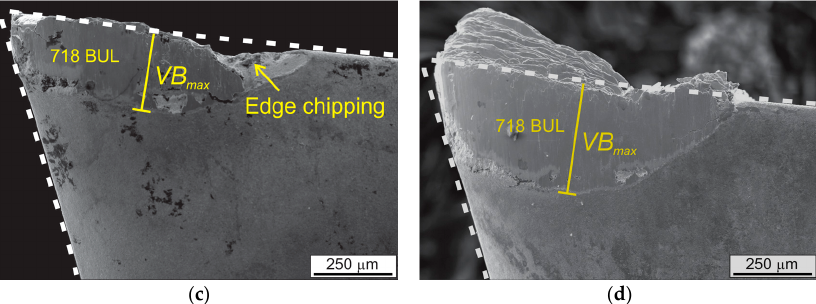
Figure 3. Scanning electron microscope (SEM) images of Tool dry1 side flank face after various milling passes: ( a ) after the first pass, ( b ) after the second pass, ( c ) after the third pass, and ( d ) after the fourth pass. Zero pass edge outline (ZPEO) of the tool is placed in each image.